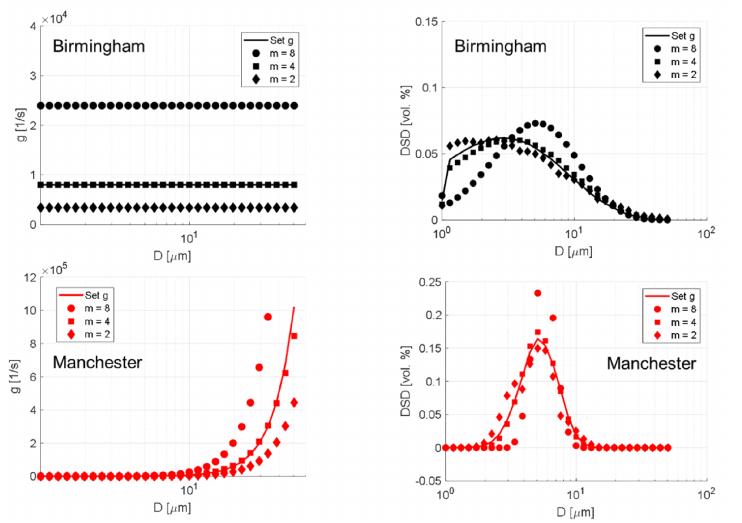
Figure 4. Sensitivity of the different methods to the choice of m . Left column compares set fragmen- tation rates obtained by m = 4 (solid lines) to estimations using a range of assumed m -values ( m = 2, 4, and 8). The right column compares the validation data DSD after 20 passages (solid lines), to the DSD predicted based on the different m -assumptions. Showing the Birmingham method (top row) and the Manchester method (lower row).